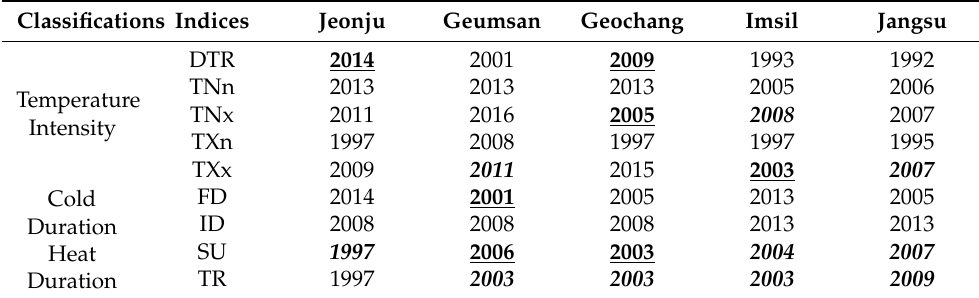
Table 3. Results of MWP test for change point detection in temperature indices. Classifications Indices